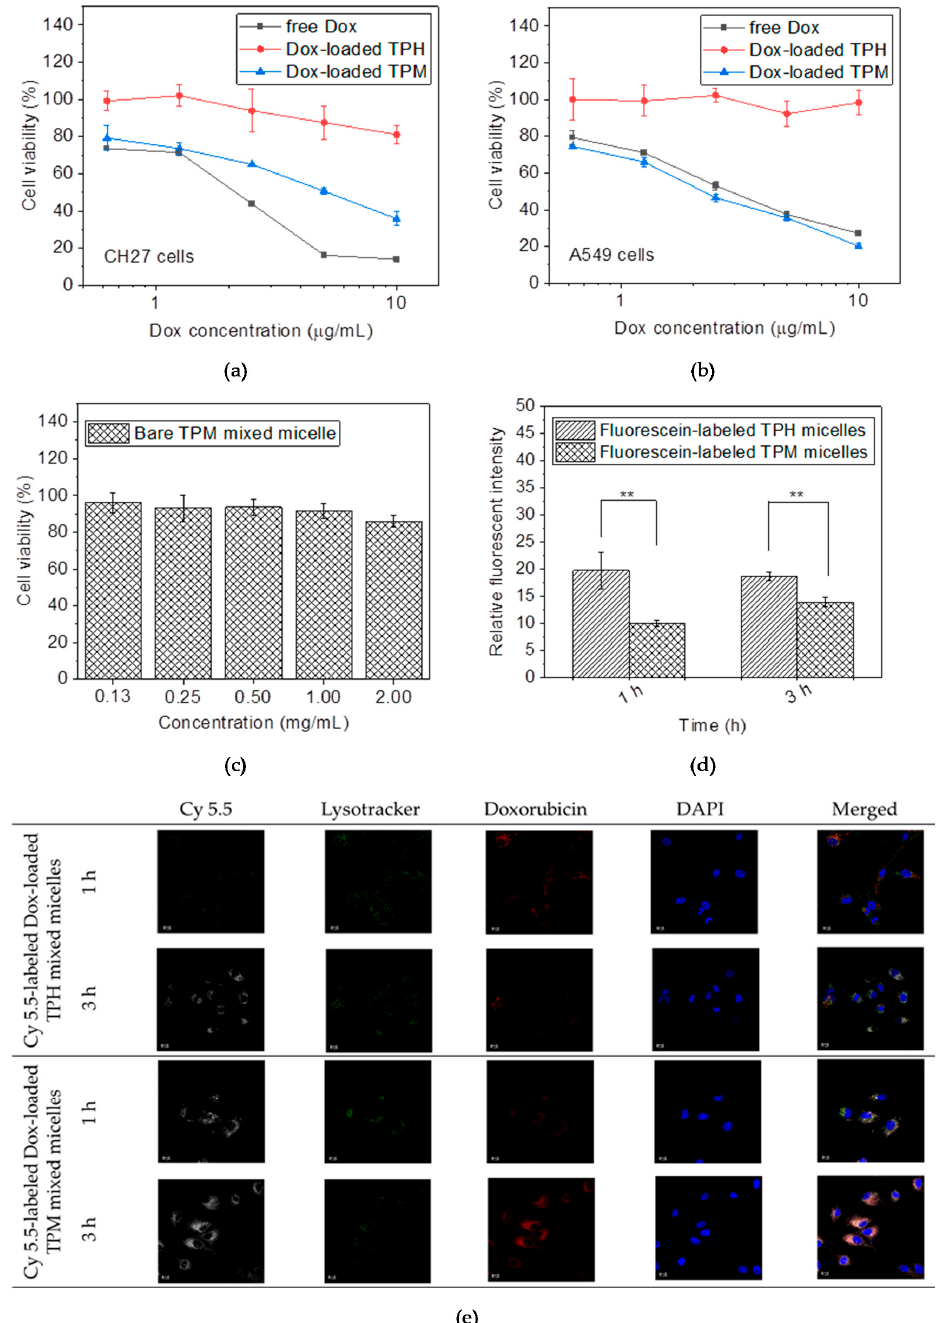
incubated for 3 h. The overall fluorescence intensity of cells treated with TPH mixed micelles was higher than that of cells treated with TPM mixed micelles.